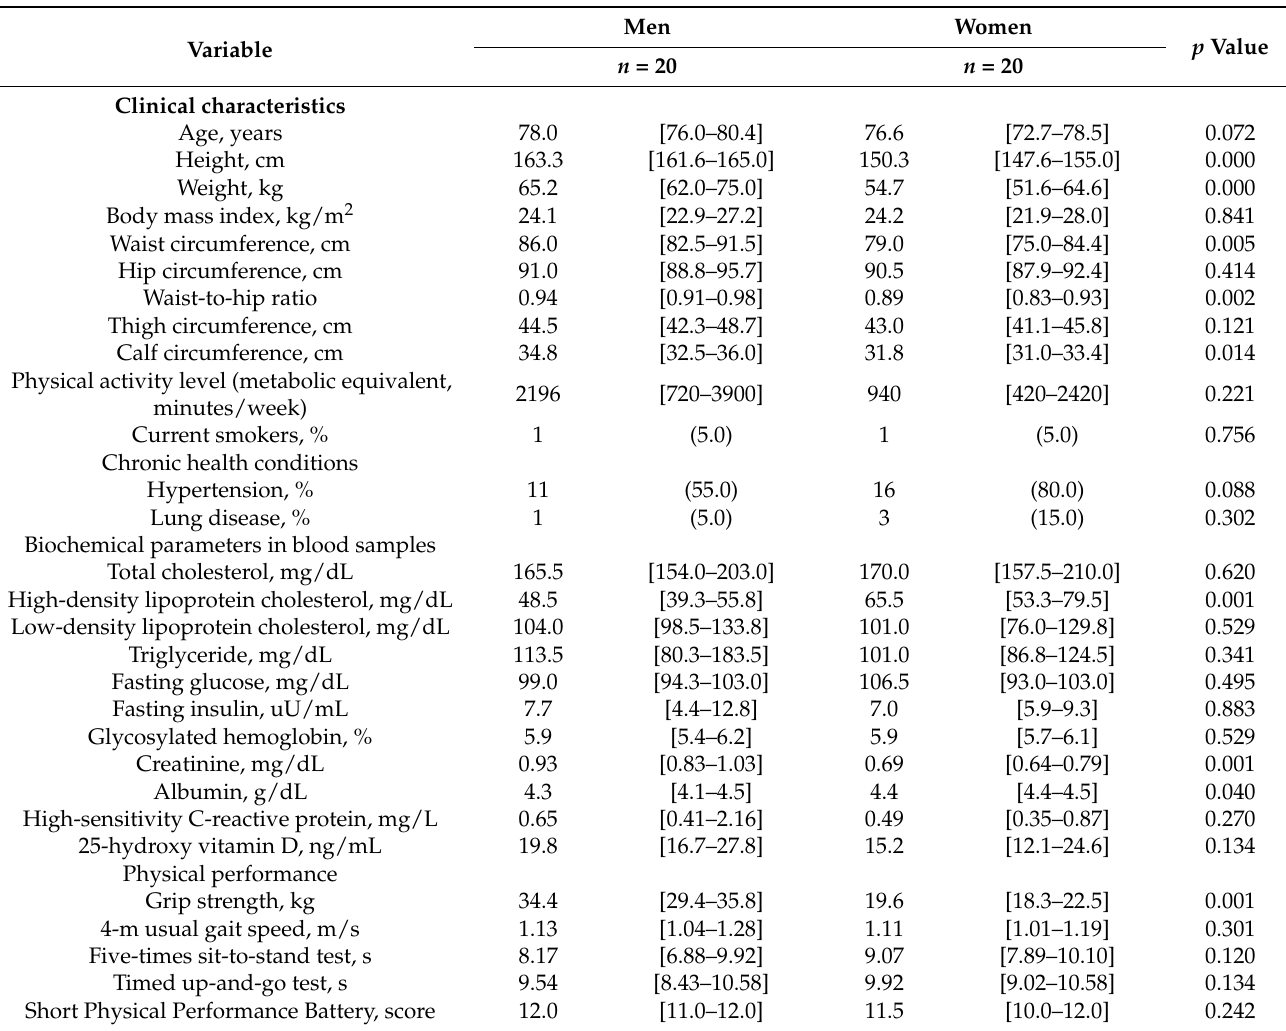
Table 1. Clinical characteristics of the study